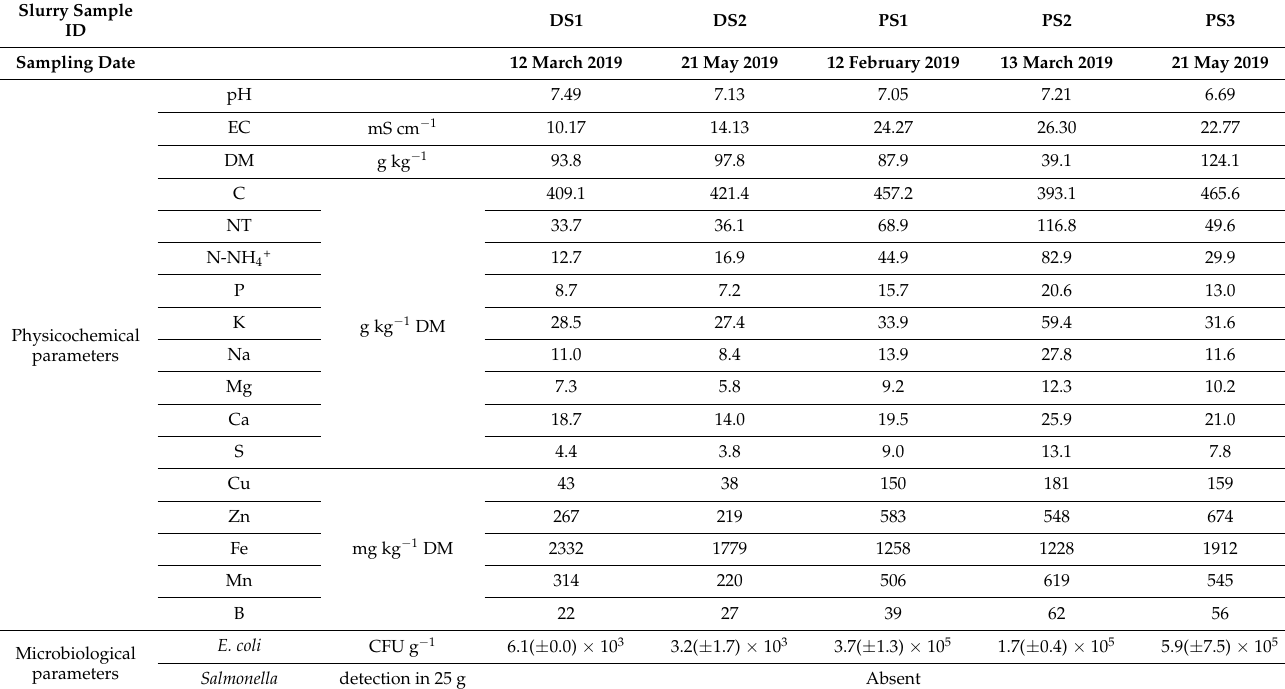
Table 1. Physicochemical and microbiological characterization of raw dairy slurry samples (DS1, DS2) and raw pig slurry samples (PS1, PS2, PS3) (Mean, n =